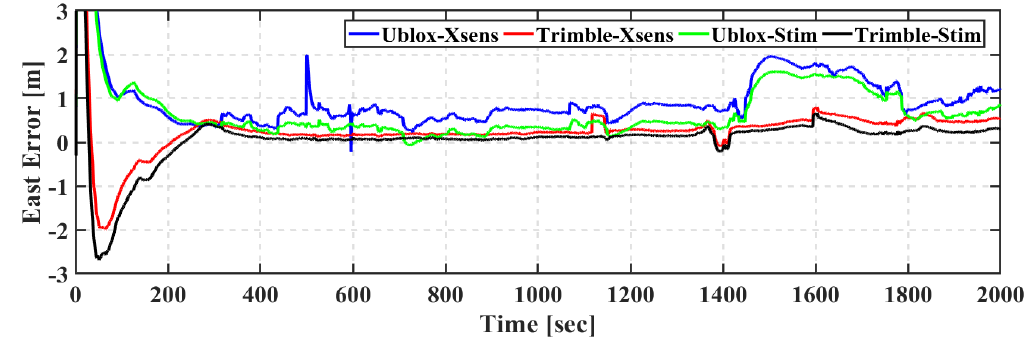
Figure 19. Third field trial: East positioning error of real-time TC GNSS PPP/INS for Ublox–Xsens, Trimble–Xsens, Ublox–Stim, and Trimble–Stim solutions.